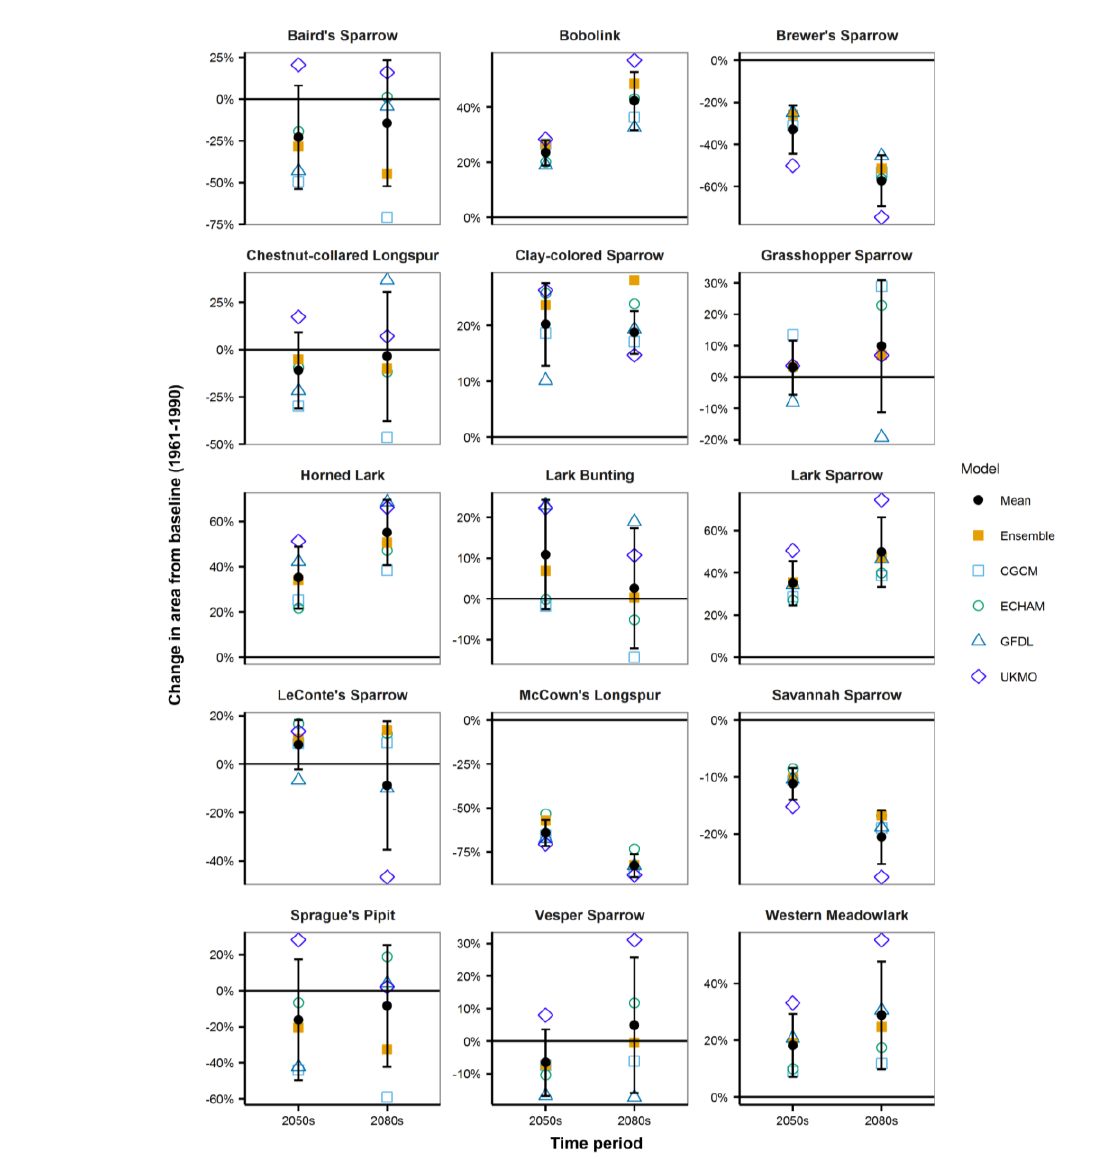
Figure A5.1. Projected changes in core suitable climate area in North America from the historical baseline (1961-1990) for the 2050s (2041-2070) and the 2080s (2071-2100). The mean change (± 95% CI; black circles) is determined from the four unique GCMs (CCCMA CGCM3.1; MPI ECHAM5/MPI-OM; GFDL CM2.1; UKMO-HadGEM1; open symbols). Changes in areas projected using ensemble climate data (yellow squares) correspond to the maps in Figure